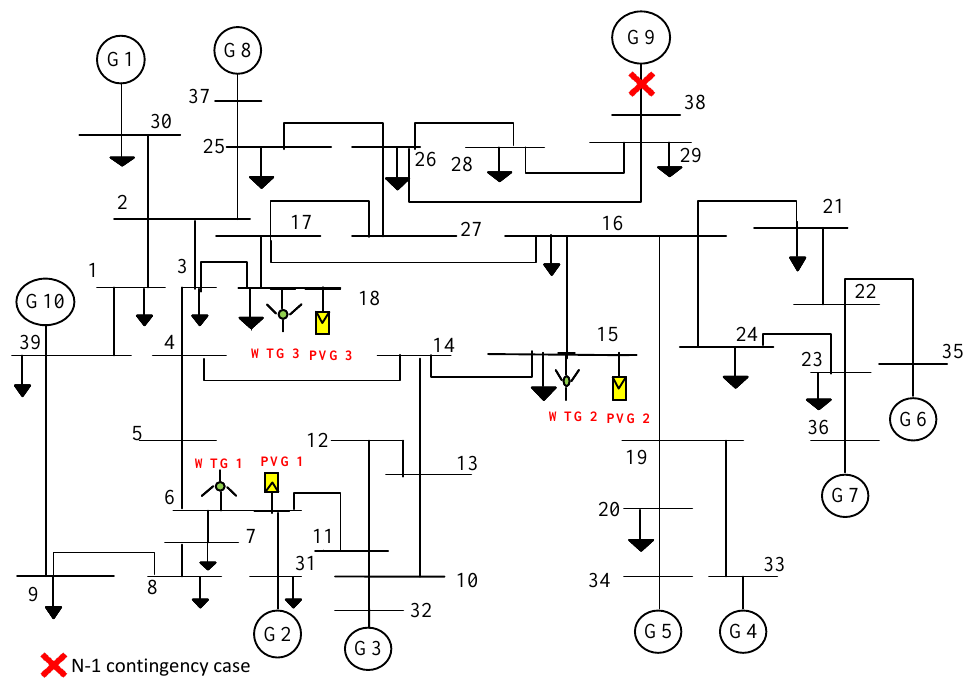
Figure 10. New England 39 Bus